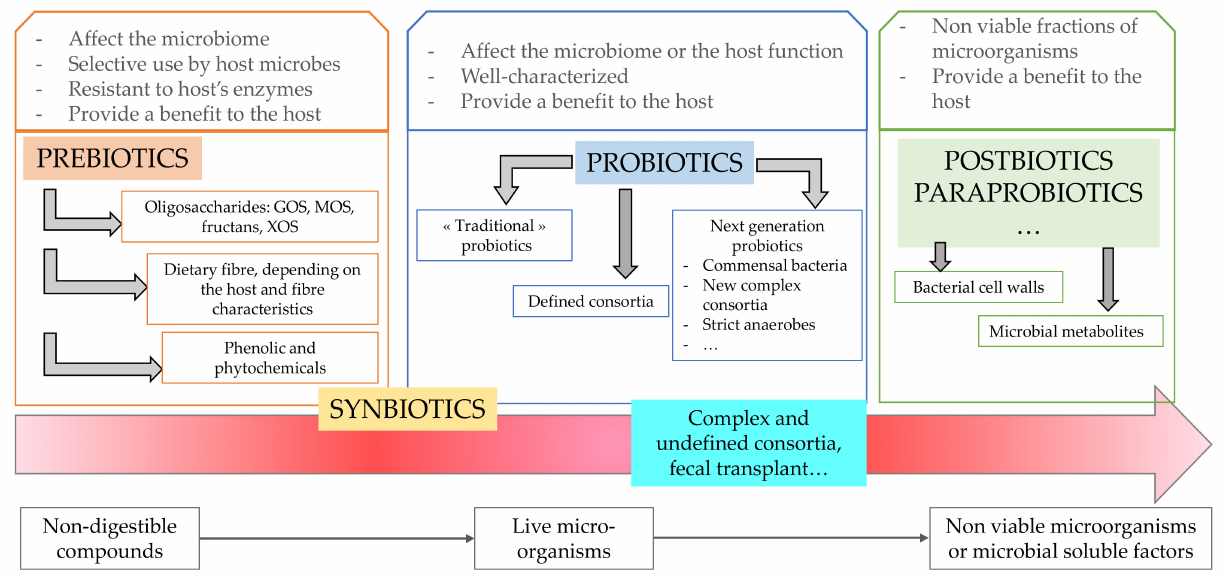
Figure 6. Possible strategies using biotics for horse nutrition and health